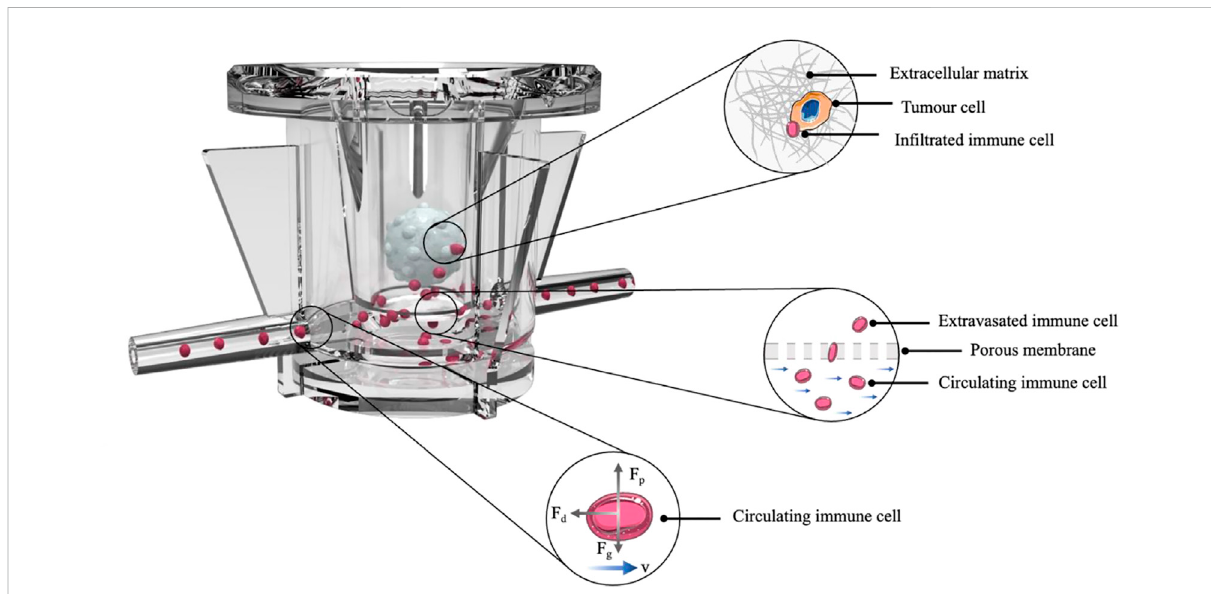
FIGURE 5 Organonchipplatformforimmune-tumorcellscross-talk.Representativeschemeoftheexperiment:HTLA-230 cellswereembeddedina3D alginate scaffold and cultured above a microcirculation of NK cells, for 4 h.